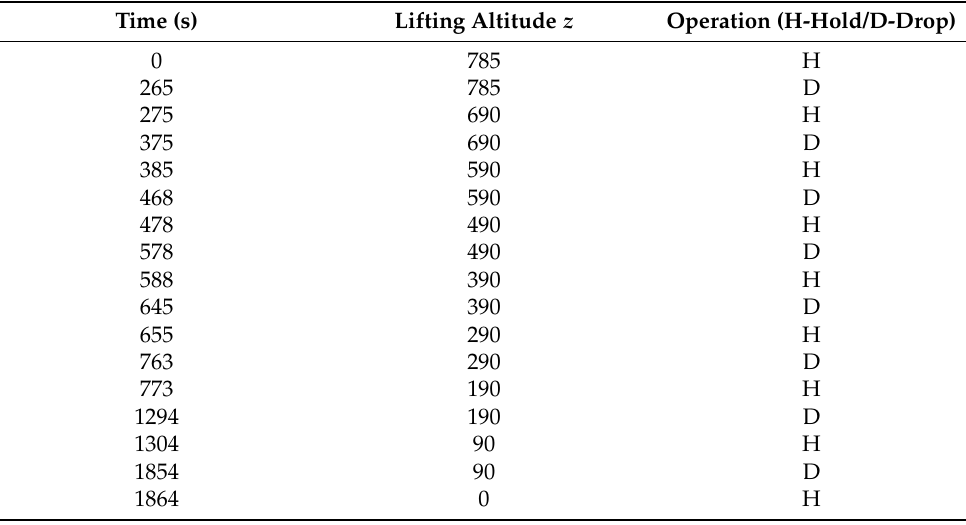
Figure 12. A schematic of ground test. Table 2. Lifting altitudes of the lifting platform and operations at different time.